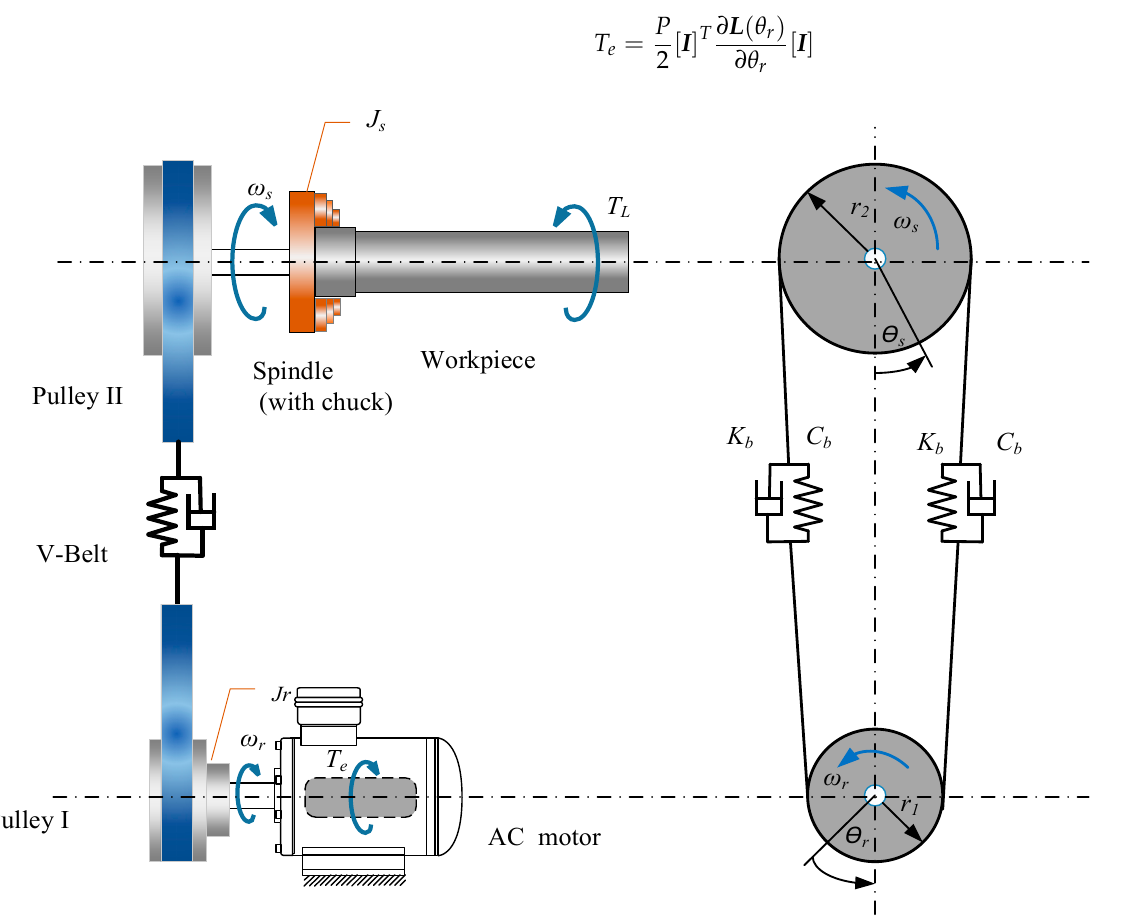
Figure 3. Schematic of a belt-driven electromechanical spindle system.